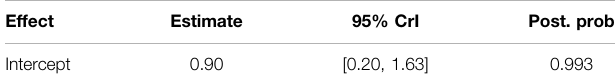
TABLE 2 | Results from statistical analysis — estimates of the model, corresponding95%credible intervals(95% CrI) and theposteriorprobabilities (Post. Prob.). Effects for which the CrI excludes zero are shown in bold. In this intercept-only model ‘ Intercept ’ denotes the effect of selecting CVG more often than